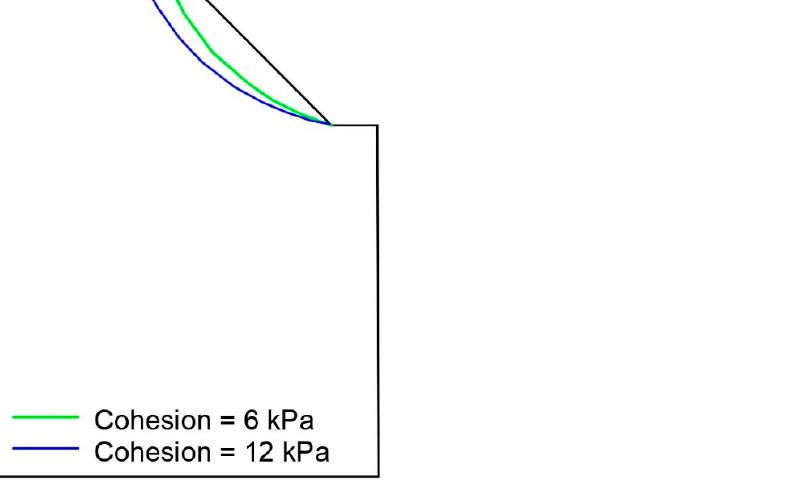
Figure 5. Effect of cohesion on static failure surface determined from limit equilibrium method.